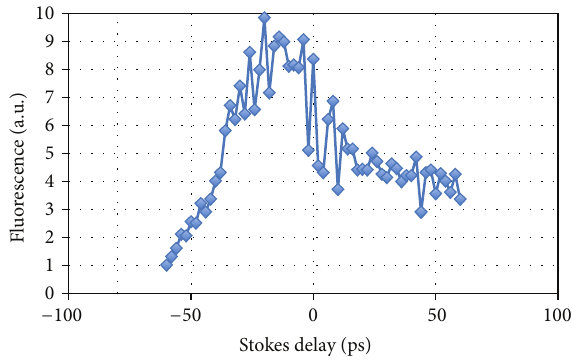
Figure8:STIRAPonsodiumvapor.AStokesdelayof0corresponds to perfect temporal overlap of the pump and Stokes pulses. Positive delays (pump before Stokes) correspond to SEP; negative delays (Stokes before pump) correspond to